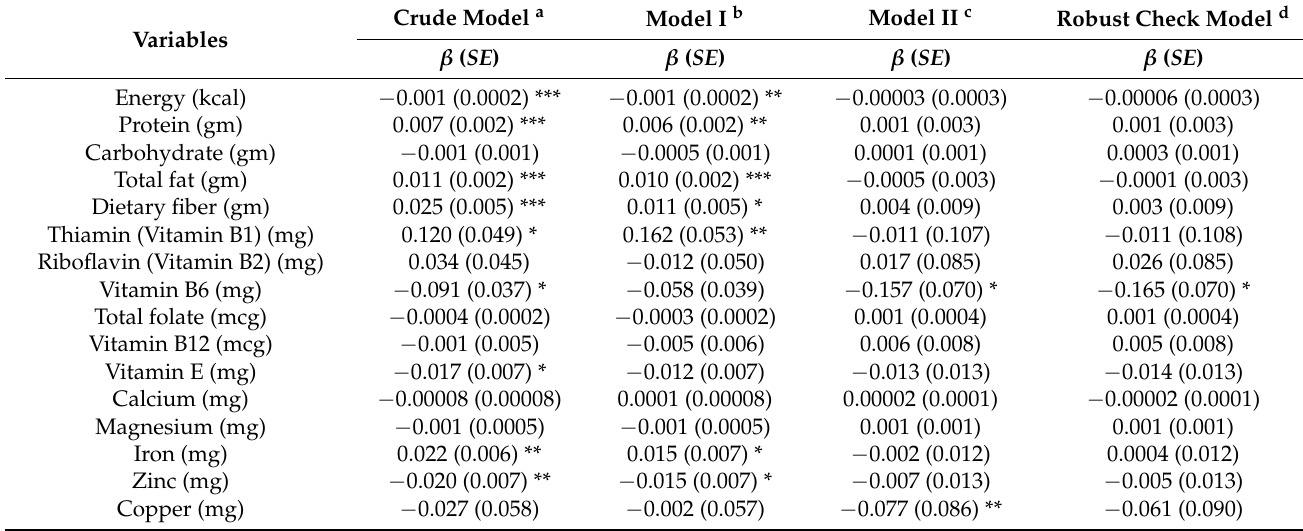
Figure 2. Forest plot for odds ratio (OR) and 95% confidence interval (CI) of daily total dietary nutrient and energy intake (( A ) without covariates; ( B ) gender, age, and race were controlled; ( C ) all potential confounders in the study were controlled; ( D ) all potential confounders and the years fixed effect in the study were controlled). Table 2. Binary logistic regression analysis between RGCS and dietary nutrient and energy intake among non-pregnant adults 20+ years old from NHANES 1999–2018 (except for 2003–2004).